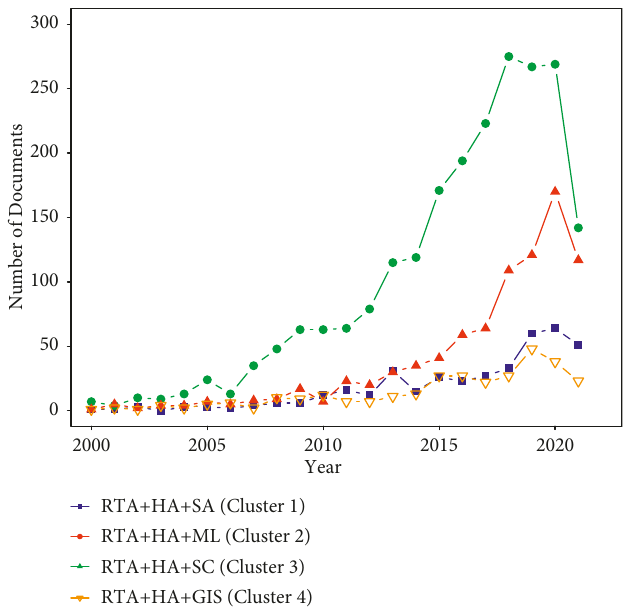
Figure 1: Time series of the scientific production of each cluster. Table 1: Top 20 most cited papers in the clusters RTA+HA +SA, RTA +HA +ML, RTA +HA +SC, and RTA+HA